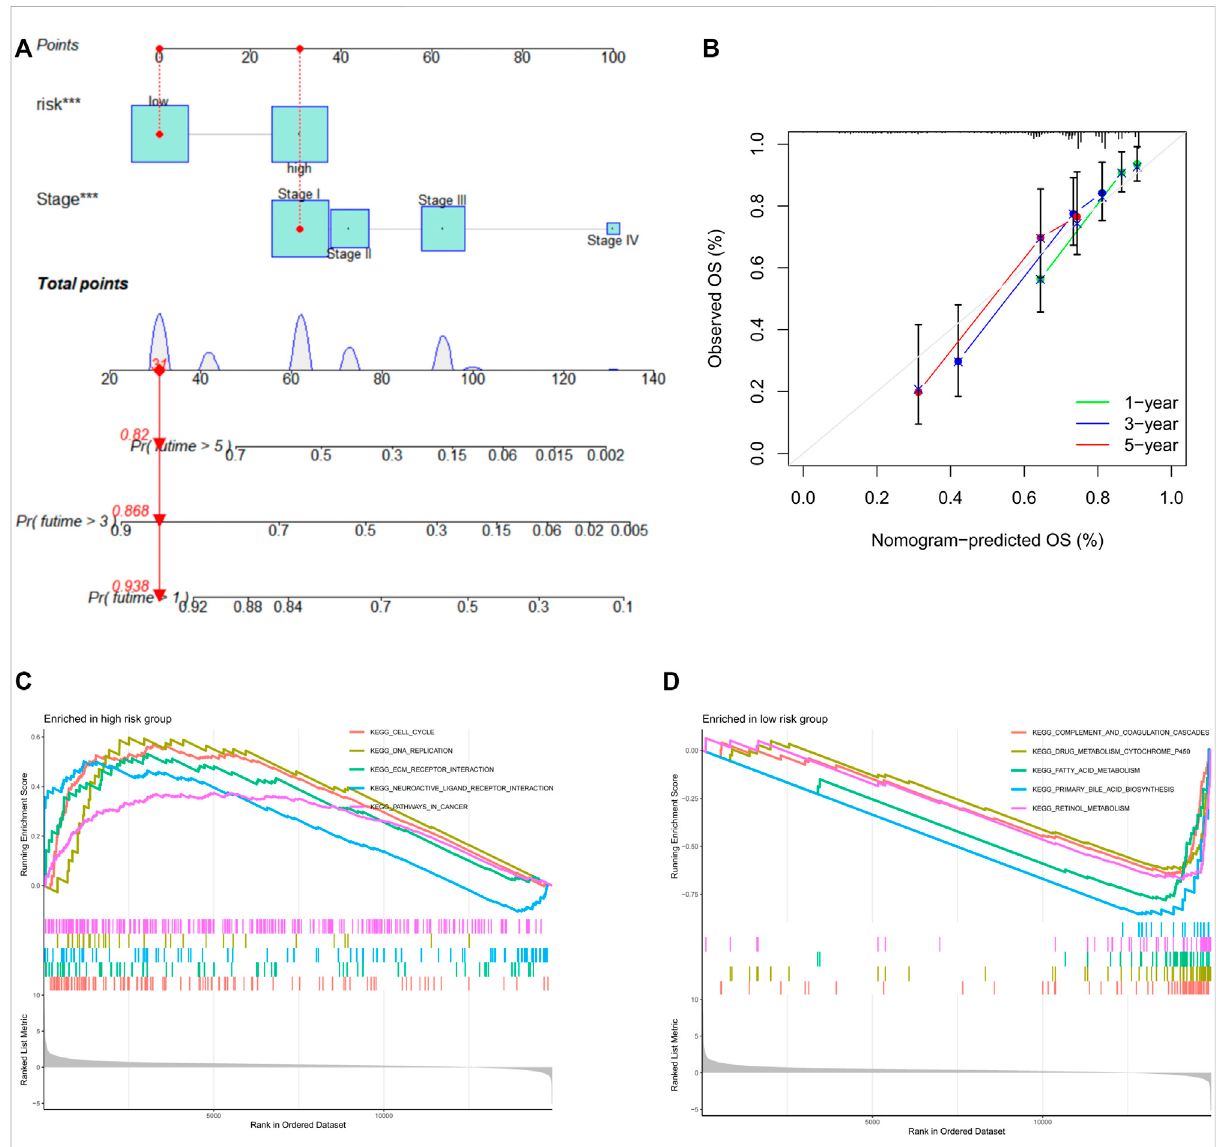
FIGURE 8 Nomogram prognostic model. (A) Nomogram constituting stage and risk score for predicting 3- and 5-year overall survival probability. (B) Calibration curves for the performance evaluation of the nomogram prognostic model. X -axis: nomogram predicts OS; Y -axis: actual OS. (C) GSEA results of the high-risk group. (D) GSEA results of the low-risk group. GSEA: Gene Set Enrichment